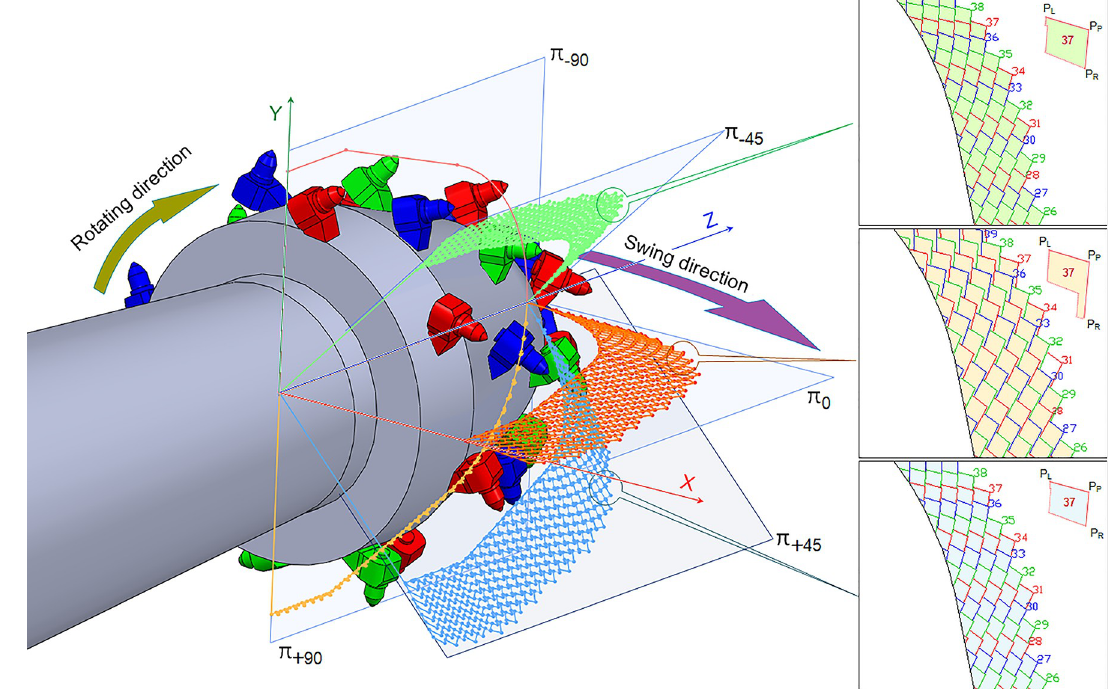
Fig 10. Pick rotation coefficient on different cutting